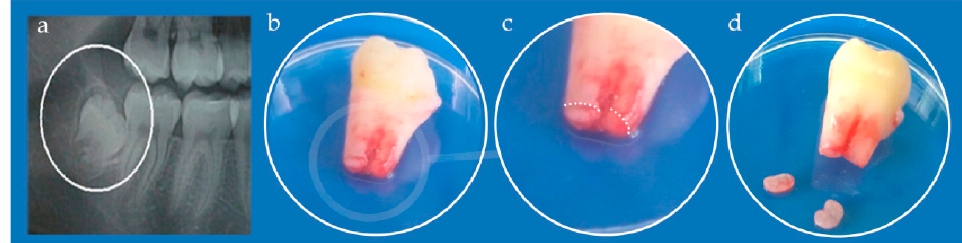
Figure 3. ( a ) Orthopantomogram of right mandibular impacted third molar (encircled); ( b ) Ex- tracted tooth; ( c ) Detail from ( b ) white dotted line depicts border between apical papilla (lower parts) and tooth root (upper part); ( d ) Kidney-shaped apical papilla tissues separated from the